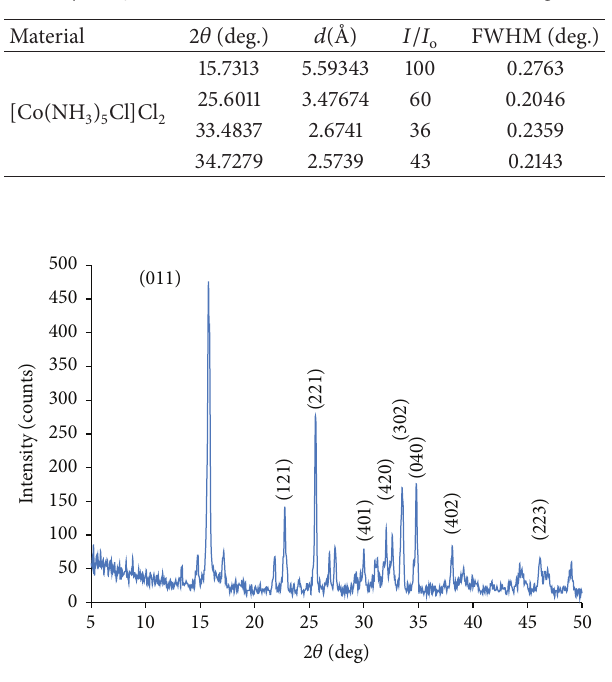
Figure 1: XRD pattern for [Co(NH 3 ) 5 Cl]Cl 2